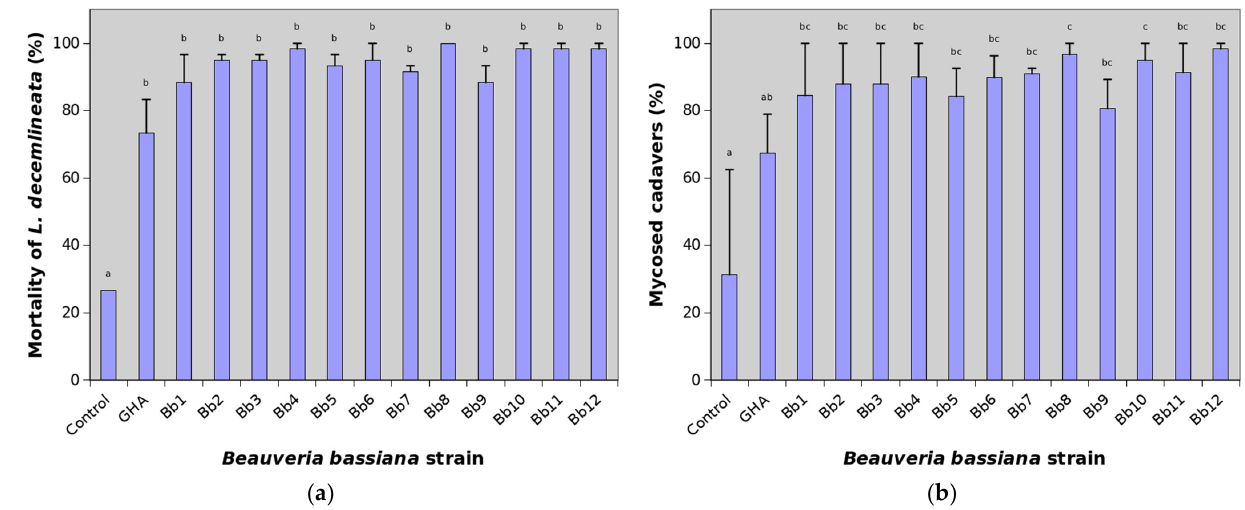
Figure 2. Percentage of mortality and mycosed cadavers of Leptinotarsa decemlineata adults treated with various strains of Beauveria bassiana 21 days after treatment. See Table 1 for the key to the strains. Data presented are means (± SE), with two replicates of 30 beetles for each strain. A generalized linear model was fitted and pairwise between treatment differences were tested using the least-square means. Different letters indicate significant differences between columns ( P < 0.05). ( a ) Mortality; ( b ) Mycosed cadavers.